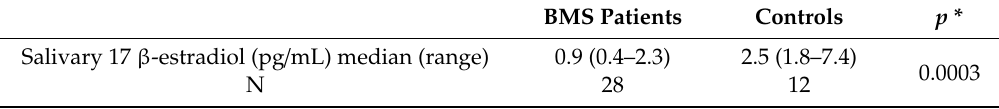
Table 1. Salivary 17 β -estradiol levels in burning mouth syndrome (BMS) patients and controls.